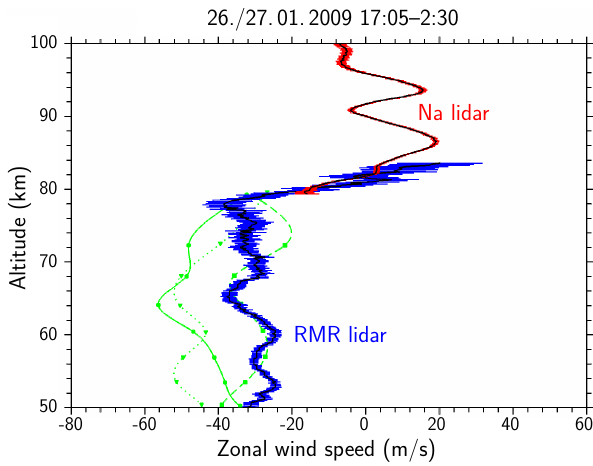
Fig. 8. Left panel: combined vertical profile of zonal wind speed measured with the NWT; below 82km altitude RMR lidar data are shown, above 82km Na lidar data; the black line shows a poly- nomial fit of fourth degree representing the estimated background wind speed. Right panel: residual between measured wind speed and estimated background highlights perturbations in the vertical wind profile; the black lines show an envelope indicating the expo- nential increase of the perturbation amplitude.